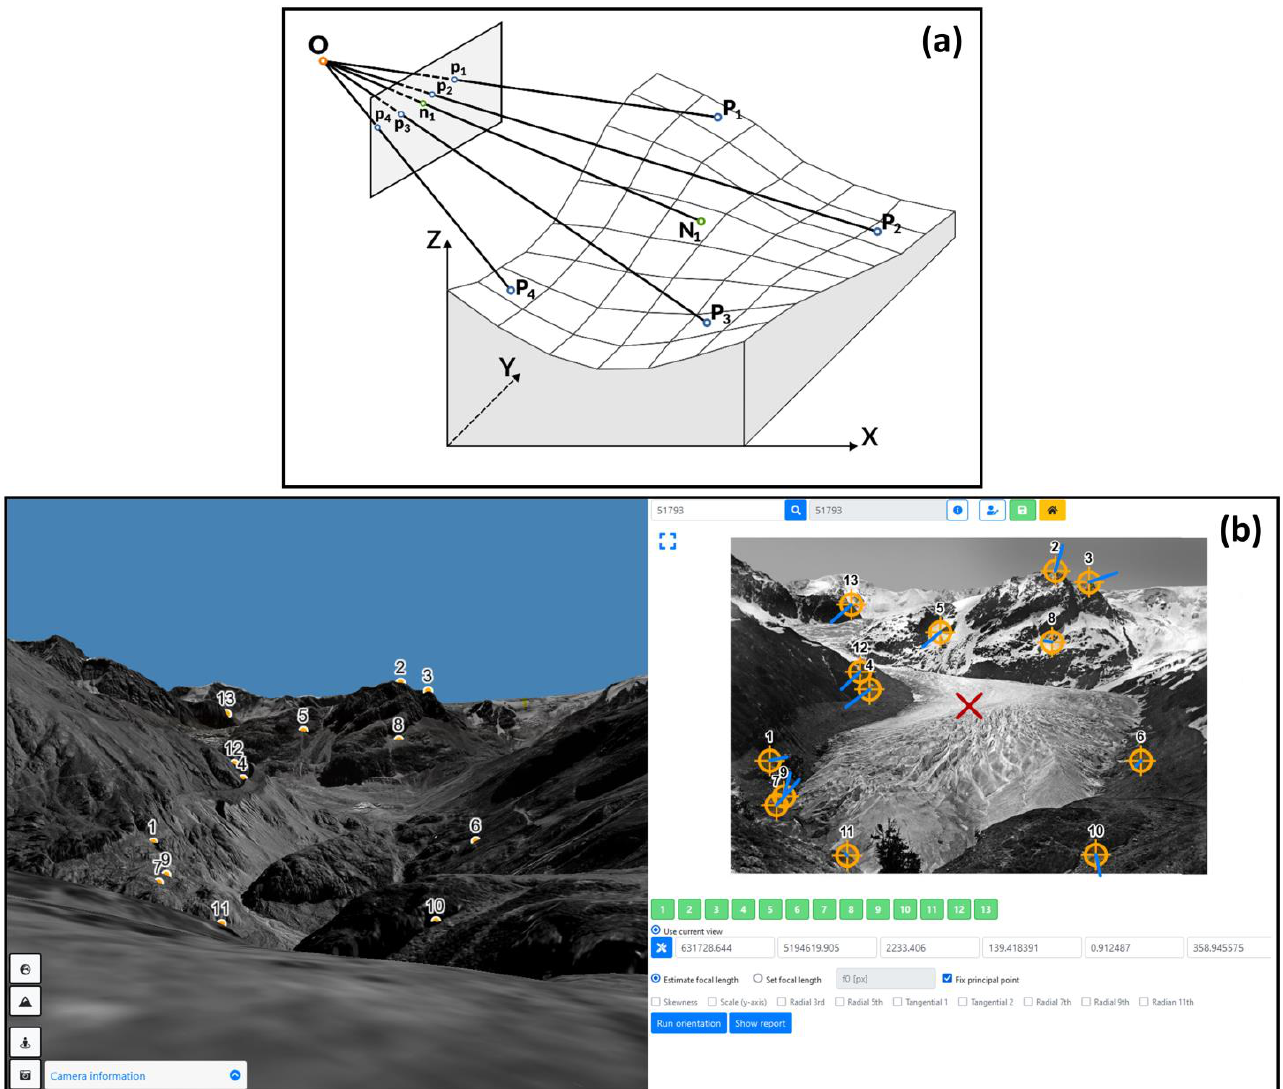
Figure 3. ( a ) GCPs (P1–P4) both in the image and object space can be used to estimate the unknown camera parameters. Using the estimated camera parameters, the position of an image point (n1) can be calculated in the object space (N1) by monoplotting. Figure adapted from Kraus [44]. ( b ) Selection of ground control points on the 1890 photograph in the 3D Viewer and the following calculation of the camera